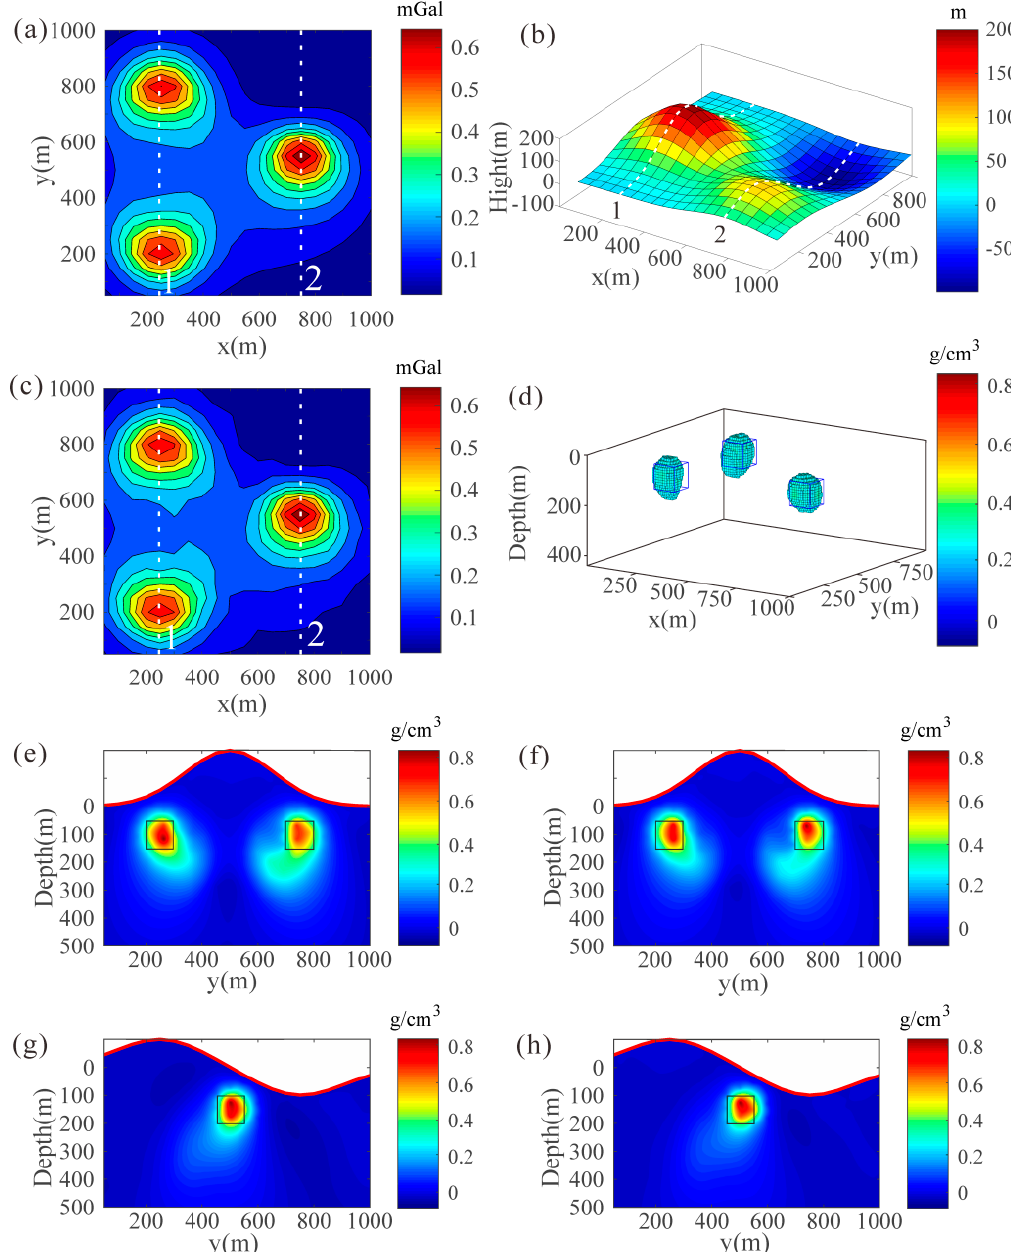
Figure 5. Gravity inversion under complex terrain. ( a ) Gravity anomalies; ( b ) surface topography; ( c ) gravity anomalies containing noise; ( d ) 3D view of inversion results; ( e ) slice at x = 250 m of inversion results; ( f ) slice at x = 250 m of inversion results computed with noise; ( g ) slice at x = 750 m of inversion results; ( h ) slice at x = 750 m of inversion results computed with noise.